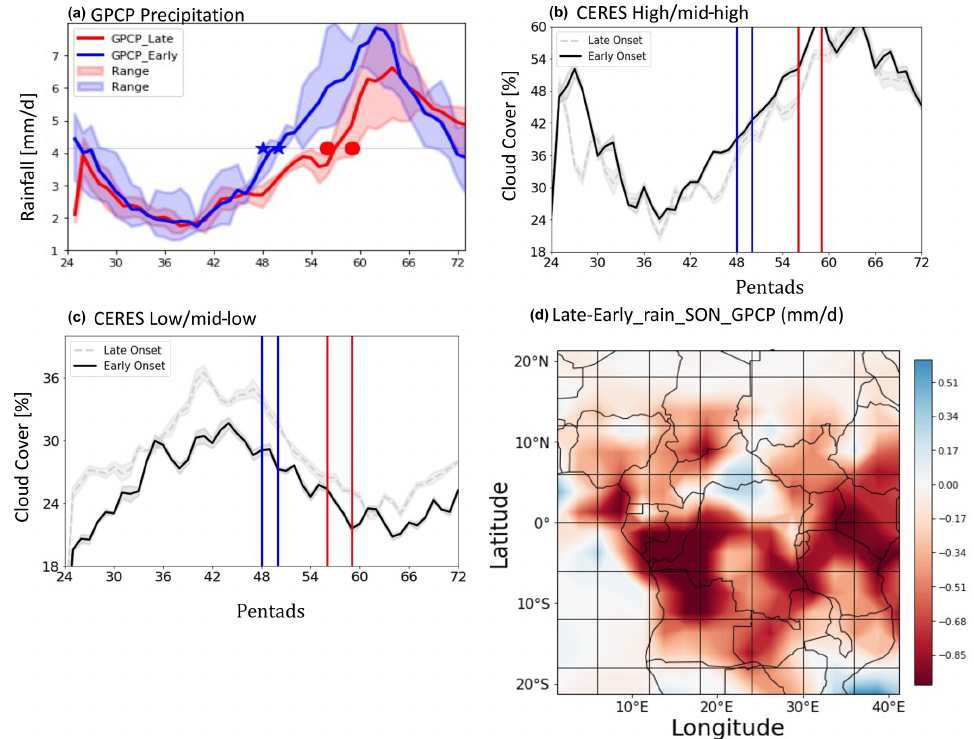
Figure 2. (a) Mean precipitation time series during the early- (blue) and late-onset (red) years at each pentad. Blue stars (red circles) represent the timing of the early- (late-)onset years. Rainfall ranges represent precipitation of individual early- or late-onset years. Mean high and mid- high cloud cover (b) and low and mid-low cloud cover (c) during the early- and late-onset years. Vertical lines show the ranges of onset times during the early (blue) and late (red) years. (d) Maps of precipitation differences between the late- and early-onset years using GPCP data. The shading indicates two sigma errors.